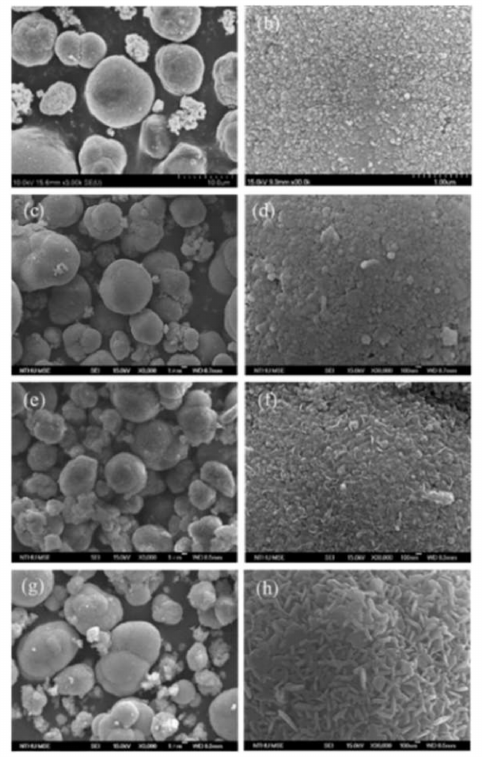
Figure 1. SEM images of ( a , b ) LR–Bare, ( c , d ) LR–Sp1, ( e , f ) LR–Sp2.5, and( g , h ) LR–Sp5 precursors. The precursors were calcined with the required amount of LiOH at 900 ◦ C to form LR–Bare, LR–Sp1, LR–Sp2.5, and LR–Sp5 cathodes, and their morphologies are shown in Figure 2. The spherical primary particles of the LR–Bare cathode grew to 100 nm, whilst the primary particles of LR–Sp1, LR–Sp2.5, and LR–Sp5 also became spherical, with size grow- ing alongside the increasing concentration, to eventually reach a diameter of approximately 200–300 nm. The secondary particle morphologies of all cathodes presented microsphere aggregation, and their mass median diameters (D 50 ) and true densities increased with the coating concentration. The mass median diameters (D 50 ) of secondary particles for LR–Bare, LR–Sp1, LR–Sp2.5, and LR–Sp5 cathodes were 7.2, 7.8, 8.6, and 8.9 µ m, respectively, as shown in Figure 3. Meanwhile, the true densities of these cathodes were 4.02, 4.12, 4.18, and 4.28 g cm − 1 ,